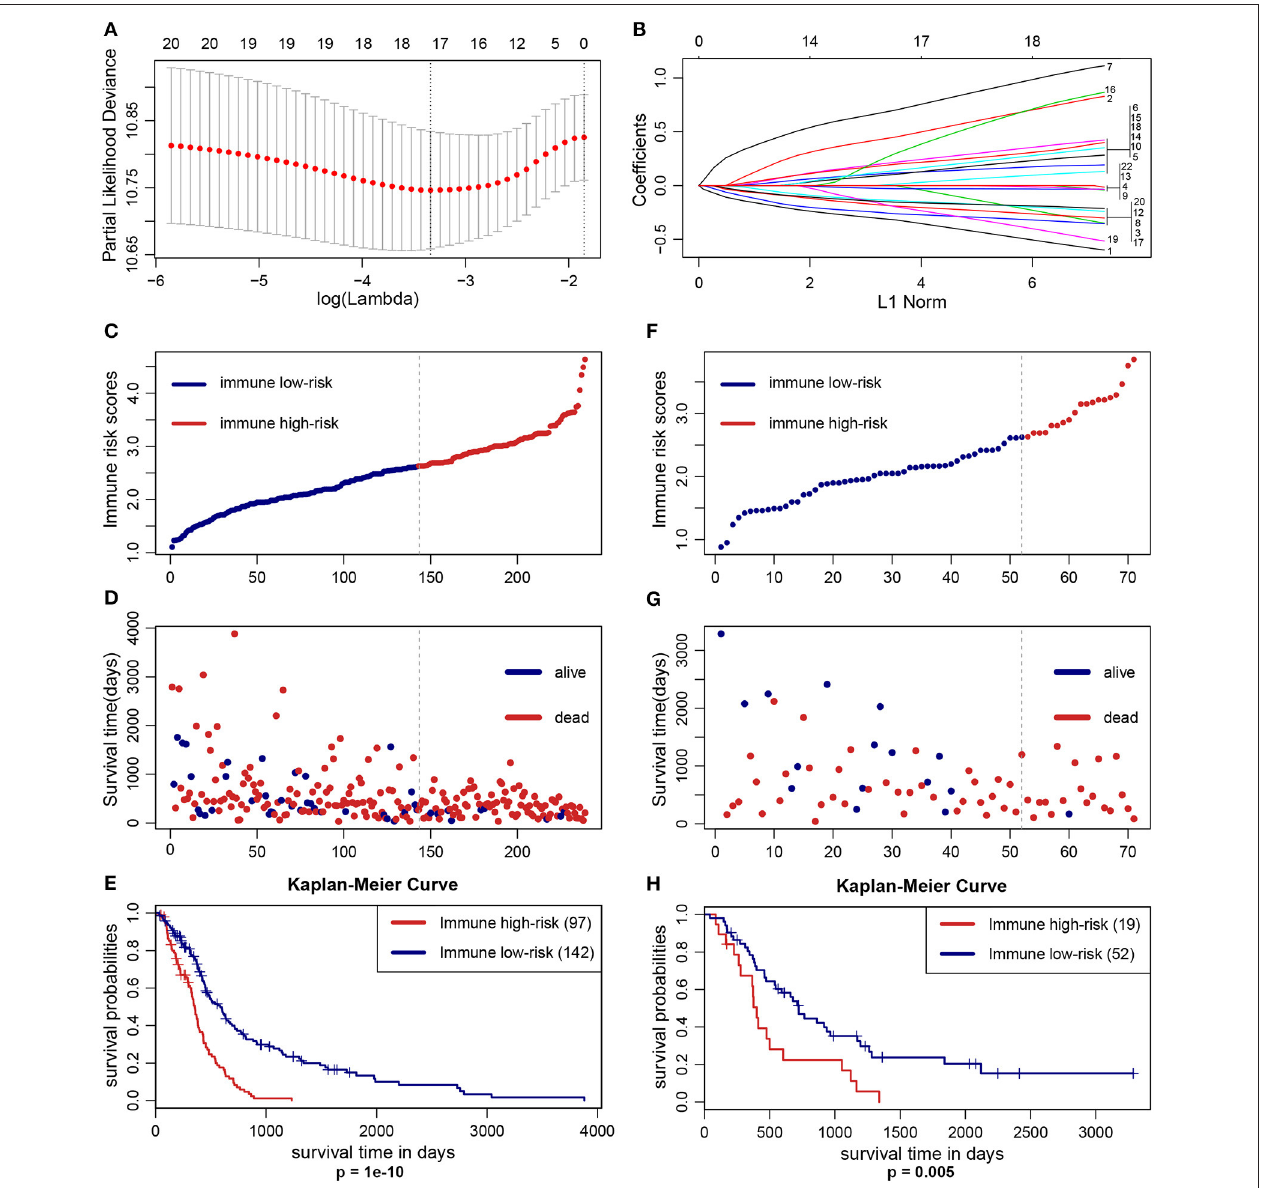
FIGURE 1 | Construction and validation of the IIRPSS. (A,B) 17 types of immune cells selected by LASSO Cox regression analysis. Left: using 10-fold cross-validation to the optimal penalty parameter lambda. Right: LASSO coefficient profiles of the immune-infiltrating cells. (C–E) Distribution of the IIRPSS in the training (TCGA) cohort. Upper panel: classification of patients into different immune risk groups based on the optimal IRS. Middle panel: distribution of patients’ survival time and status. Bottom panel: Kaplan–Meier survival curves between immune low- and high-risk groups. (F–H) Validation of the IIRPSS in the CGGA cohort. Distribution of IRS, survival status and Kaplan–Meier survival curves,